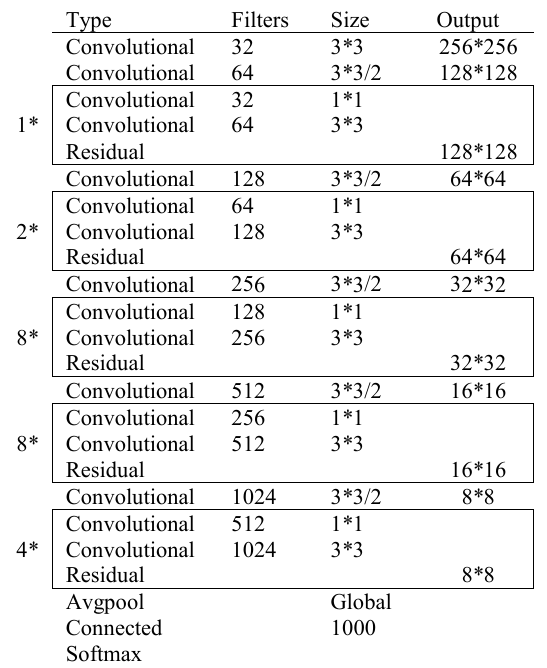
Table 1 . Darknet-53 (Redmon and Farhadi, 2018).